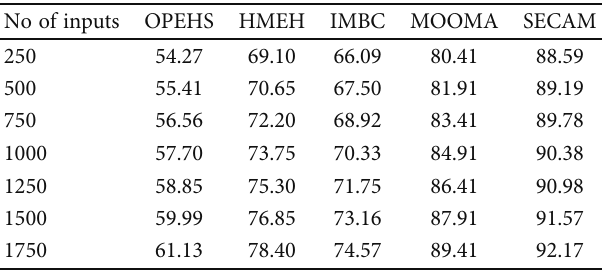
Table 6: Comparison of planning